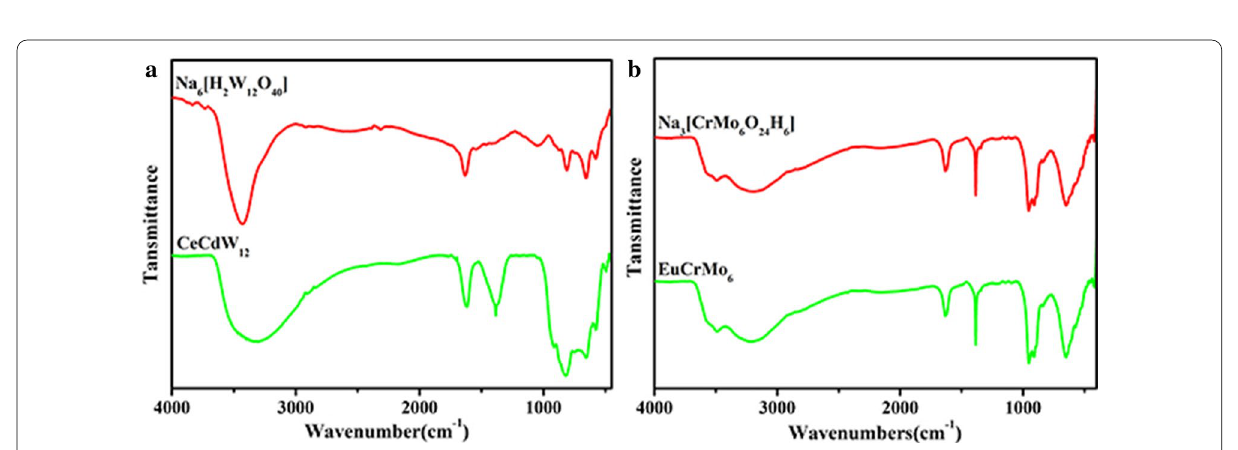
Fig. 4 a IR spectra of CeCdW 12 nanoflowers and b EuCrMo 6